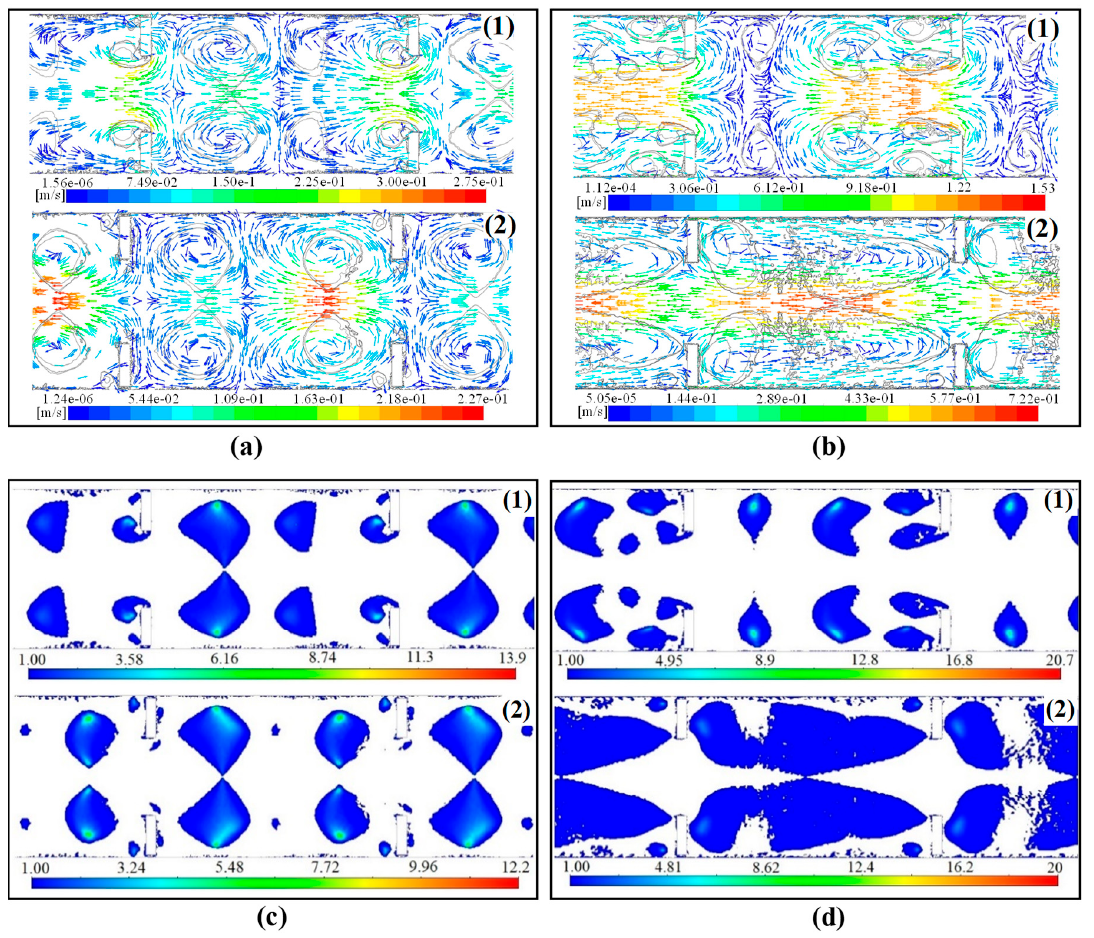
Figure 15. ( a ) Velocity vector map for f = 2 Hz and x o = 6 mm, ( b ) velocity vector map for f = 2 Hz Figure 15. (a) Velocity vector map for 𝑓 = 2 Hz and 𝑥 (cid:3042) = 6 mm, (b) velocity vector map for 𝑓 = 2 Hz and x o = 30 mm, ( c ) modified Q-criterion contour for f = 2 Hz and x o = 6 mm, ( d ) modified Q-criterion and 𝑥 (cid:3042) = 30 mm, (c) modified Q-criterion contour for 𝑓 = 2 Hz and 𝑥 (cid:3042) = 6 mm, (d) modified Q- contour for f = 2 Hz and x o = 30 mm (di ff erent phases of oscillation cycle are shown in the top corner criterion contour for 𝑓 = 2 Hz and 𝑥 (cid:3042) = 30 mm (different phases of oscillation cycle are shown in top of each corner of each plot).